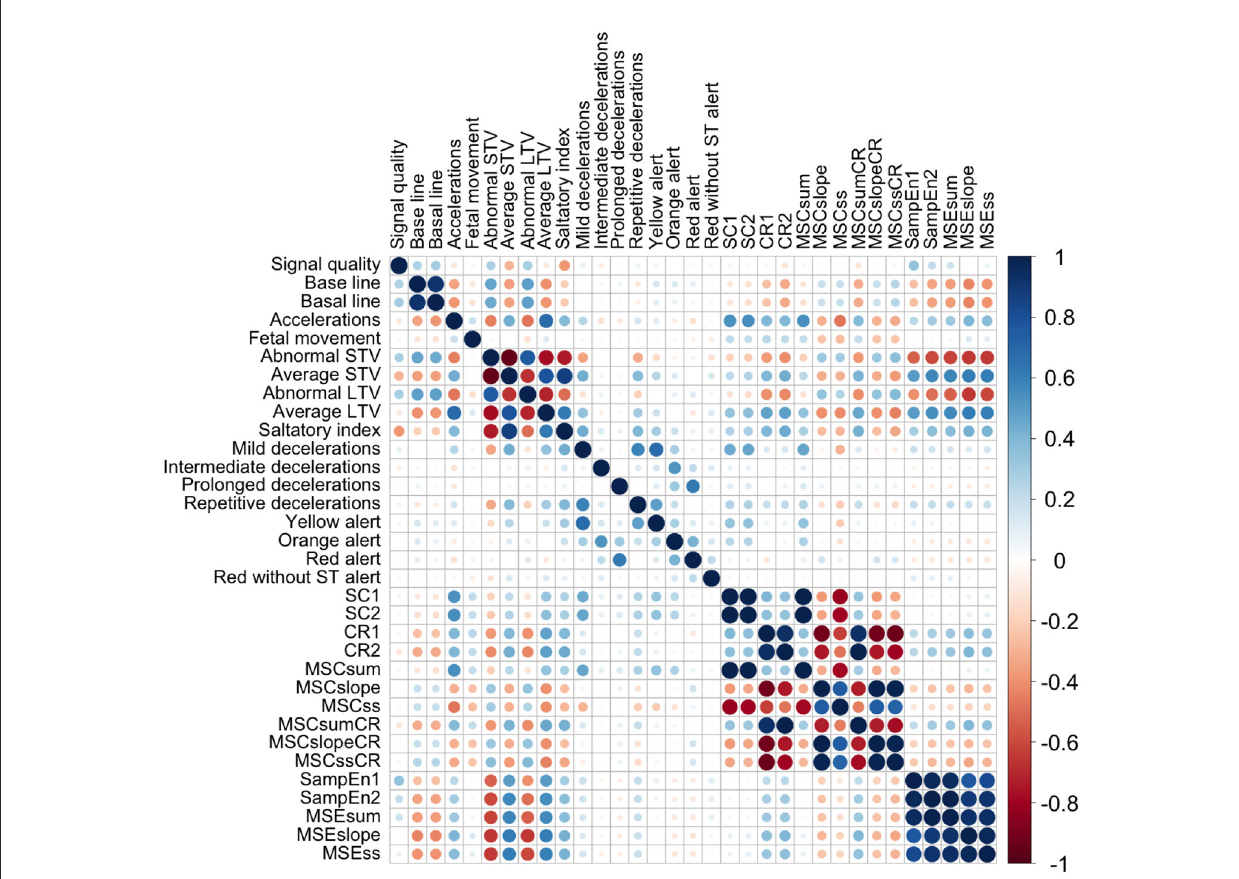
FIGURE1 Correlation plot between CTGs indices. CR1, compression ratio for scale 1; CR2, compression ratio for scale 2; MSCslope, slope of the linear regression line best fitting the compressed file size all first five scales; MSCss, product of MSCsum and MSCslope; MSCsum, sum of the compressed file size values of the first five scales; MSCslopeCR, slope of the linear regression line best fitting the compression ratio values over on the first five scales; MSCssCR, product of MSCsumCR and MSCslopeCR; MSCsumCR, sum of the compression ratio values of the first five scales; MSEslope, slope of the linear regression line best fitting the entropy values over on the first five scales; MSEss, product of MSEsum and MSEslope; MSEsum, sum of the entropy values of the first five scales; SampEn1, entropy for scale 1; SampEn2, entropy for scale 2; SC1, compressed file size for scale 1; SC2, compressed file size for scale 2; STV, short-term variability; LTV, long-term